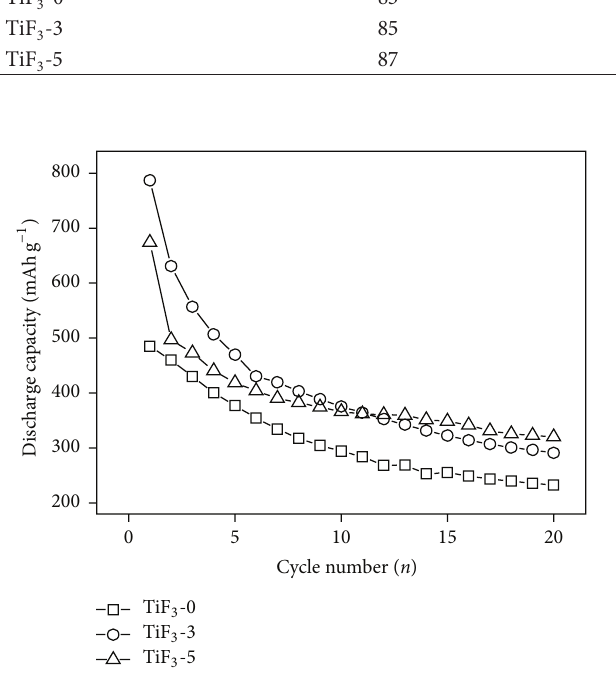
Figure 3: The charge/discharge voltage curves of the La 2 Mg 17 + 150 wt% Ni + 𝑦 wt% TiF 3 ( 𝑦 = 0, 3, 5 )